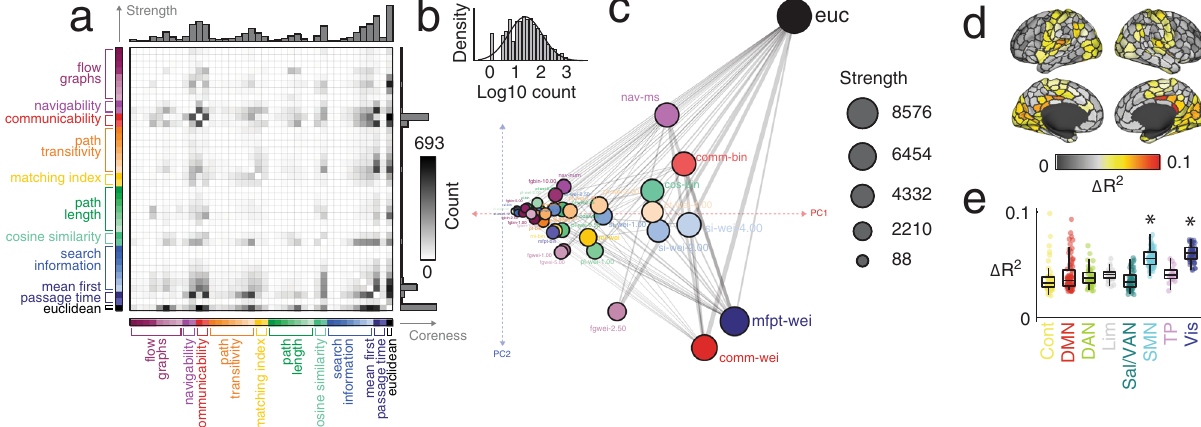
Fig. 5 Pairwise synergies between predictors. We used two-predictor multi-linear models to predict regional patterns of FC and identi fi ed the optimal pair of predictors for each region and each subject. We then counted how frequently each pair of predictors appeared in the set of optimal predictors. This procedure yields a symmetric matrix of counts ( a ). The counts were approximately log-normally distributed ( b ). The matrix could be modeled as a graph and each node ’ s (predictor ’ s) coreness could be directly calculated (node positions based on principal components analysis of count matrix) ( c ). In this plot, coordinates were determined by: 1) thresholding the count matrix to retain, for each predictor, its k = 4 nearest neighbors, and 2) performing a principal component analysis on the thresholded and symmetrized matrix. Here, the coordinates represent the fi rst two principal components, PC1 and PC2. Predictors that are near/distant from one another in principal components space pair with similar/dissimilar sets of predictors when improving R 2 . Predictors are joined by an edge if they are considered nearest neighbors. As in Fig. 2b, we did not center or z-score columns as part of the principal component analysis. We also calculated the mean regional improvement in R 2 from using the multi-linear model versus the model with a single predictor. Each point represents a brain region ( N = 400 parcels de fi ned based on 40 ). d Improvement ( Δ R 2 ) projected onto the cortical surface. e Improvement grouped by canonical brain systems (asterisks indicate statistical signi fi cance). In each boxplot, the “ box ” denotes interquartile range (IQR), the horizontal bar indicates the median value, and the whiskers include points that are within 1.5 × IQR of upper and lower bounds of the IQR (25th and 7th percentiles). Any points that fall beyond the whiskers are, by convention, considered outliers. Source data are provided as a Source Data fi